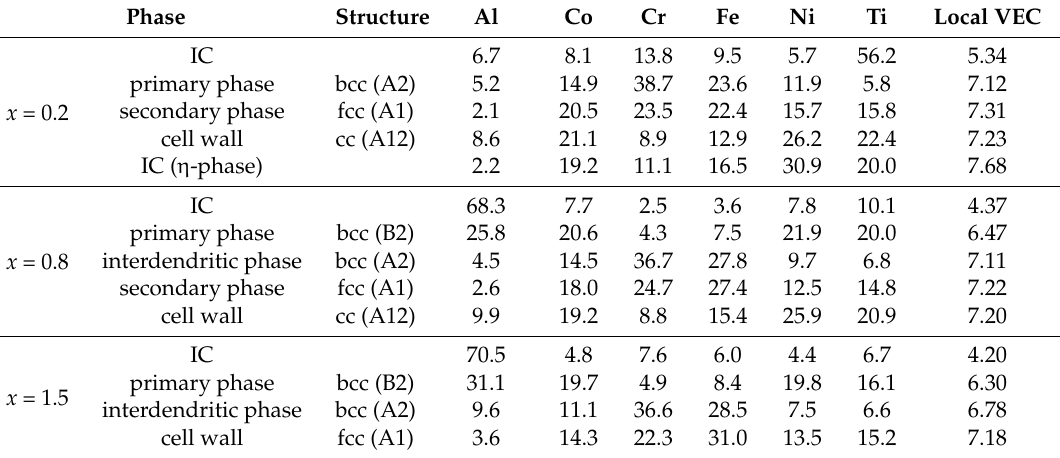
Table 4. Chemical composition of the phases in atom % measured by